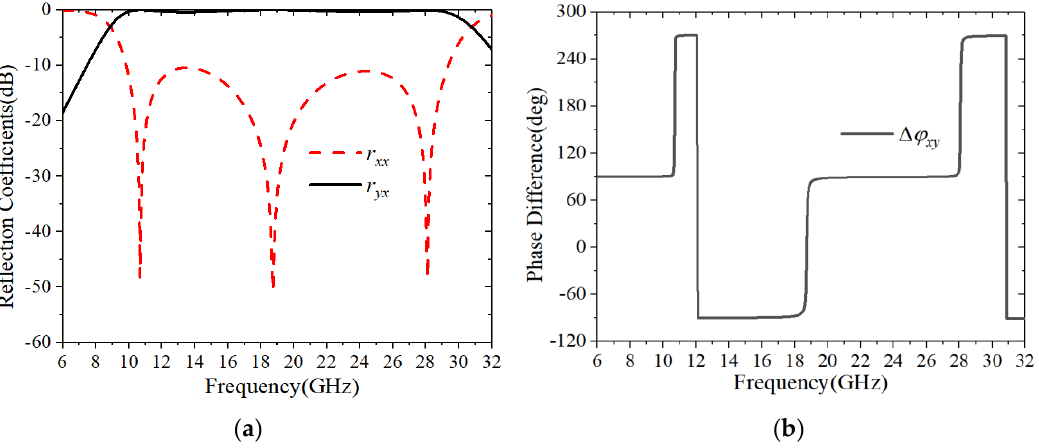
Figure 2. The simulated results of the proposed polarization converter under normal incidence for x -polarization. ( a ) The magnitudes of r xx and r yx ; ( b ) the phase difference ∆ ϕ xy between r xx and r yx .